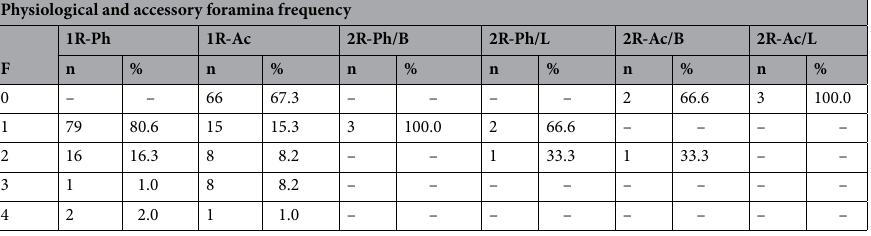
Table 2. Absolute (n) and mean (%) frequency of the physiological and accessory foramina frequency observed under micro-CT in mandibular canines (n = 101; n/one root = 98, n/two roots = 3; F = foramina frequency, 1R = single-rooted, 2R = two-rooted, B = buccal root, L = lingual root, Ph = physiological foramina, Ac = accessory canals).